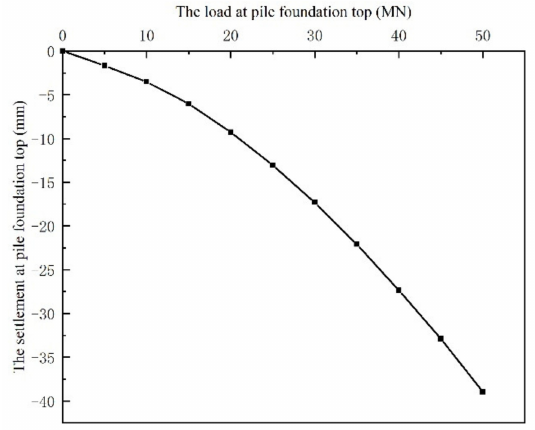
Figure 9. The relationship between the settlement and the load at the pile